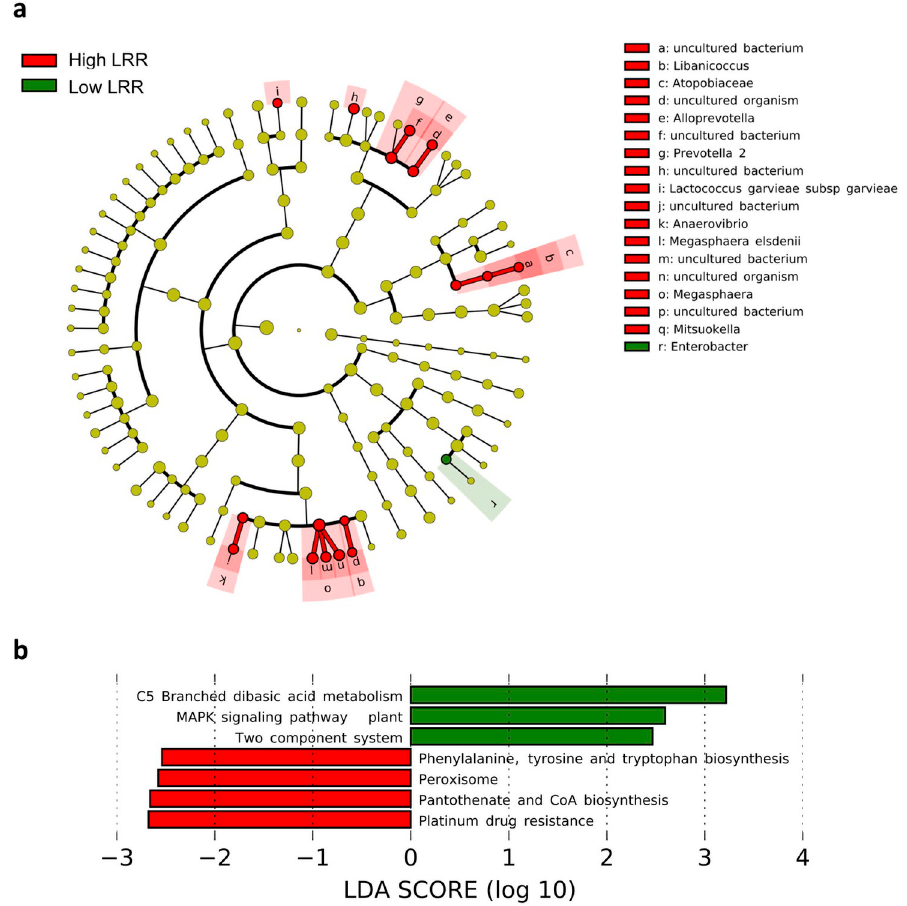
Fig 5. Fecal microbiota characterization based on lactulose-rhamnose ratios in 18–24 month old Indian children. (A) Fecal microbiota characterization cladograms of high LRR and low LRR groups based on LEfSe (linear discriminant analysis Effect Size) in the study participants. (B) Differentially abundant microbial pathways (KEGG) predicted in high LRR and low LRR groups using LEfSe analysis. An LDA cut-off score of 2 or greater and unadjusted p-value threshold of 0.05 was used to report the significant